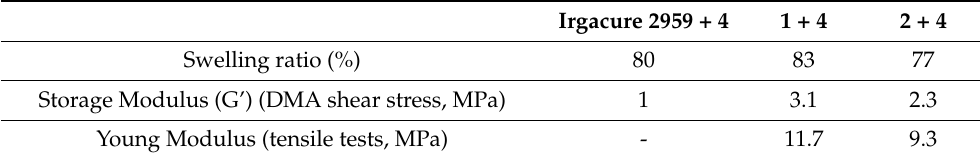
Table 1. Properties of the hydrogels prepared upon LED@395